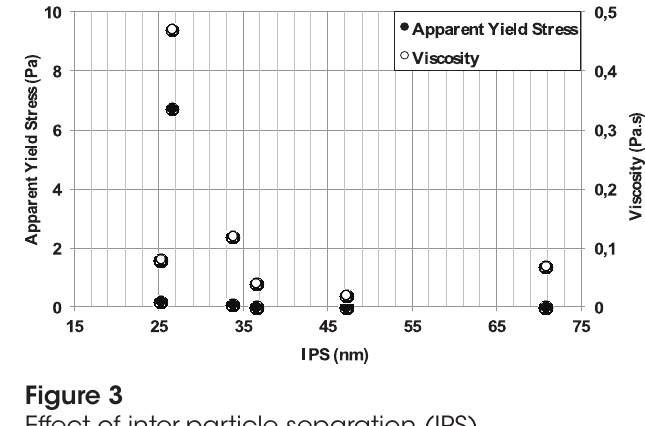
Effect of inter-particle separation (IPS) on rheological